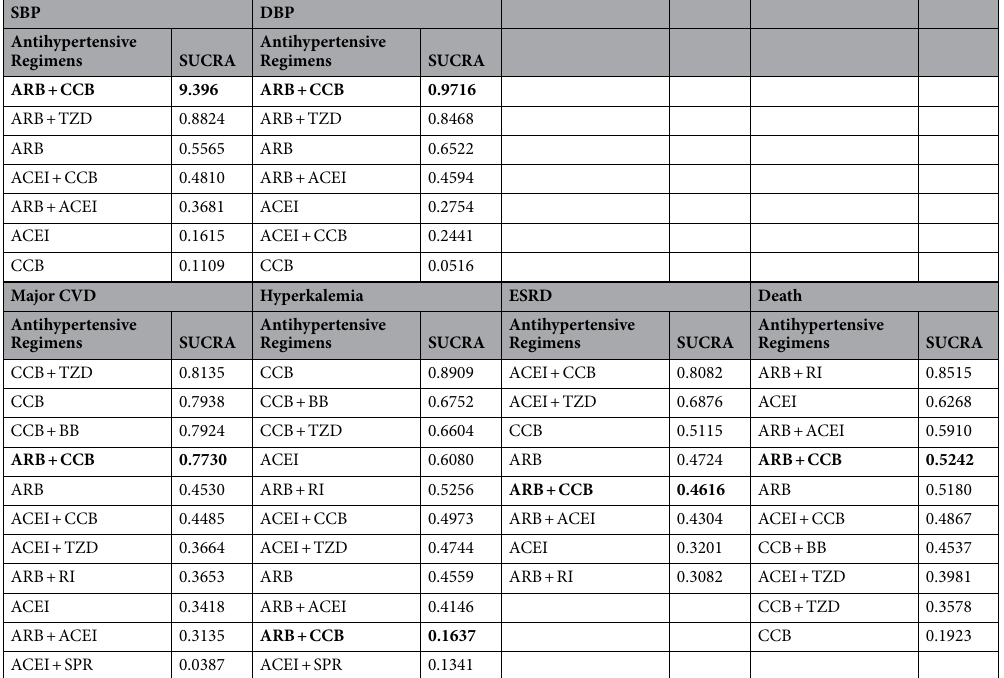
converting enzyme inhibitor; ARB, angiotensin receptor blockers; BB, beta-blockers; CCB, calcium channel blockers; CKD, chronic kidney disease; CVD, cardiovascular disease; DBP, diastolic blood pressure; DM, diabetes mellitus; ESRD, end-stage renal disease; RI, renin inhibitor; SBP, systolic blood pressure; TZD, thiazide diuretics; SPR,